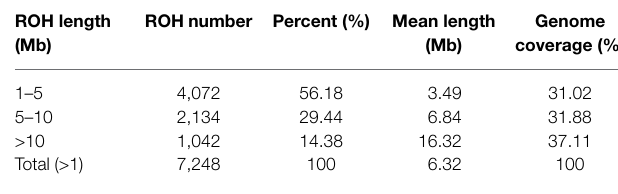
TABLE 1 | Descriptive statistics of runs of homozygosity (ROH) number and length (in Mb) by ROH length class (ROH 1–5 Mb, ROH 5–10 Mb, ROH > 10 Mb, and